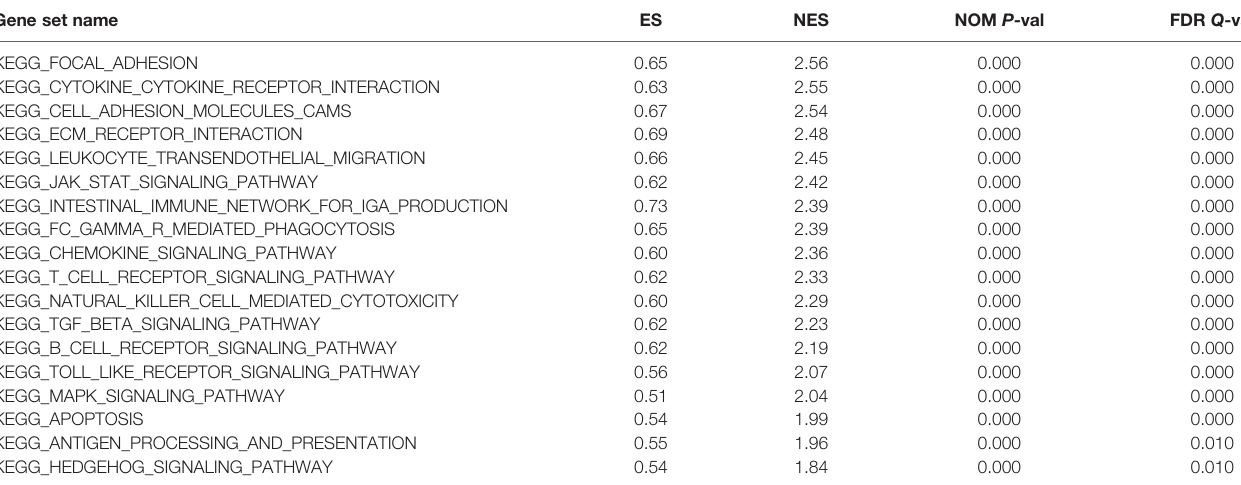
TABLE 2 | Gene sets enriched in the high-EOGT expression phenotype. Gene set